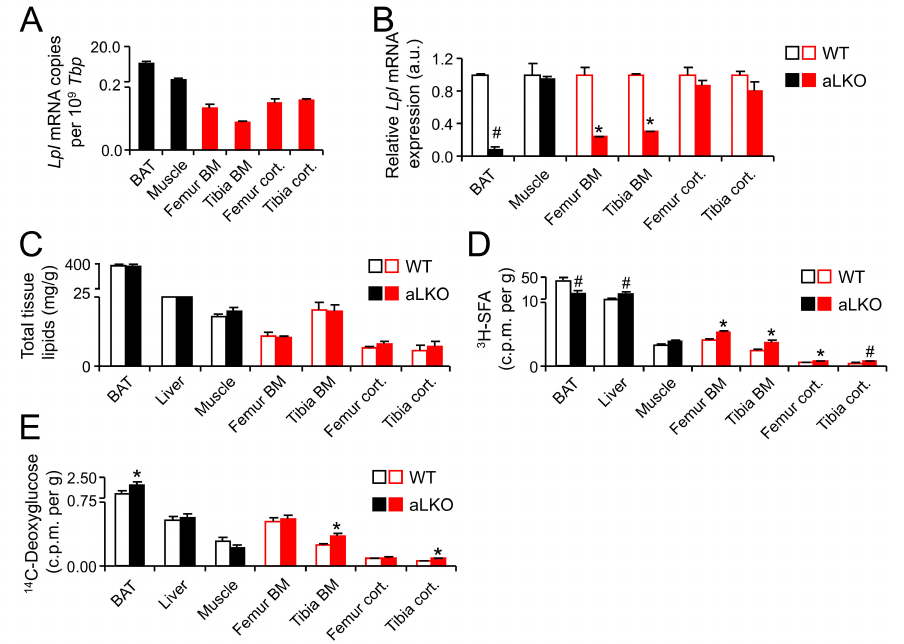
Figure 4. Nutrient handling in aLKO mice: ( A ) Quantitative real-time PCR analysis of Lpl expression in metabolically active tissues (highlighted in black) and parts of the skeleton (highlighted in red) in 12-week-old female C57BL6/J mice; and ( B ) adipocyte-specific Lpl knock-out (aLKO) mice compared to wild-type controls; ( C ) Total tissue lipids in aLKO mice and controls. Mean ± SEM; n = 5 per group; ( D ) Organ uptake of: 3 H-SFA tracers; and ( E ) 14 C-deoxyglucose after a combined oral tolerance test.